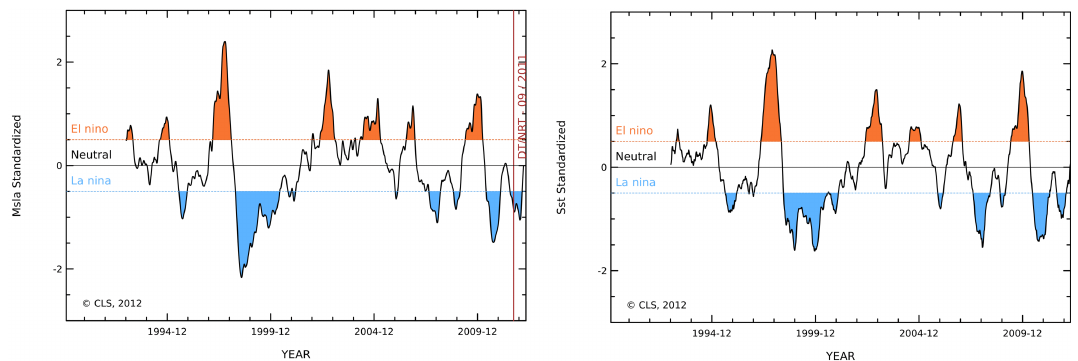
Fig. 1. Time series of SLA (left) and SST (right) divided by the respective standard deviation over the area and referenced to the 1993–2006 base period. In blue are La Ni˜na events, in red El Ni˜no.